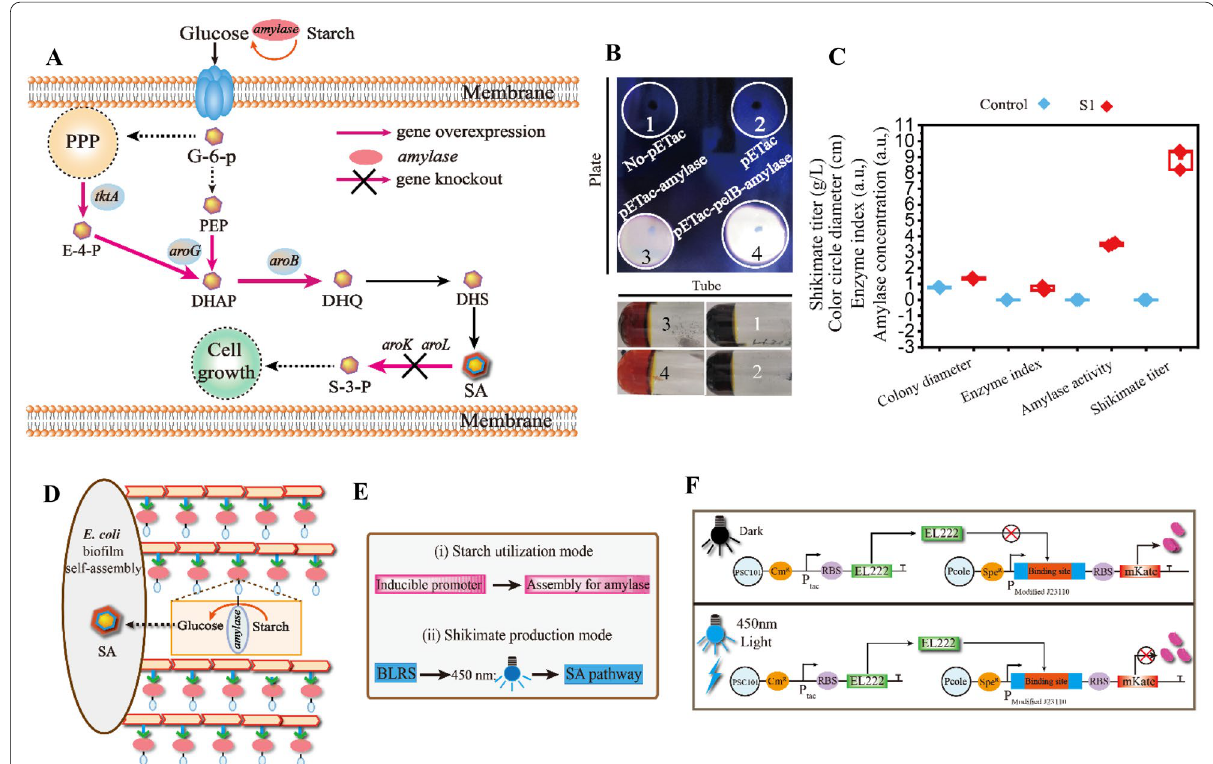
Fig. 3 Engineering shikimate synthesis by biofilm self-assembly. A The schematic diagram of shikimate biosynthesis pathway in E. coli S1. B Comparing the color circle with starch in different E. coli . C The change s of color circle diameter, enzyme index, amylase concentration, and shikimate titer in different E. coli . D Conceptual graph of starch utilization with biofilm-based SpyTag/SpyCatcher covalently protein system for L-malate production. E Conceptual graph of two modes fermentation for shikimate production. F The schematic diagram of BLRS, containing the plasmid Ptac-EL222 and PJ-mKate. For C, n 3. Error bars, mean s.d. Each gene encodes the following: Glu: glucose; G6P: glucose-6-phosphate; = ± PYR: pyruvate; PEP: phosphoenolpyruvate; AcCoA: acetyl-CoA; E4P, erythrose-4-phosphate; DAHP, 3-deoxy-D-arabino-heptulosonate-7-phosphate; Ru5P, Ribulose 5-phosphate; DHQ, 3-dehydroquinic acid; DHS, 3-dehydroshikimate; SA,